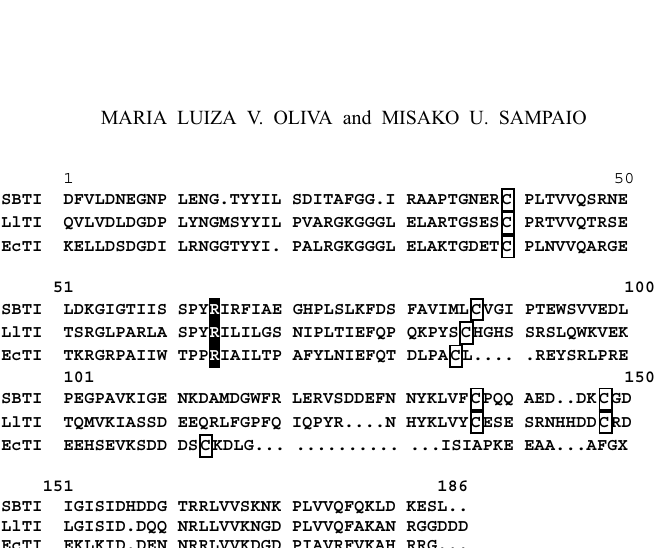
Fig. 1 – Comparative sequences of related Kunitz inhibitors SBTI (soybean trypsin inhibitor); LlTI – Leucaena leucocephala (Oliva et al. 2000) and EcTI – Enterolobium contortisiliquum (Batista et al. 1996). SBTI identical residues are in gray; the cysteine residues are indicated by black boxes. The P 1 residues of the reactive sites are in the black